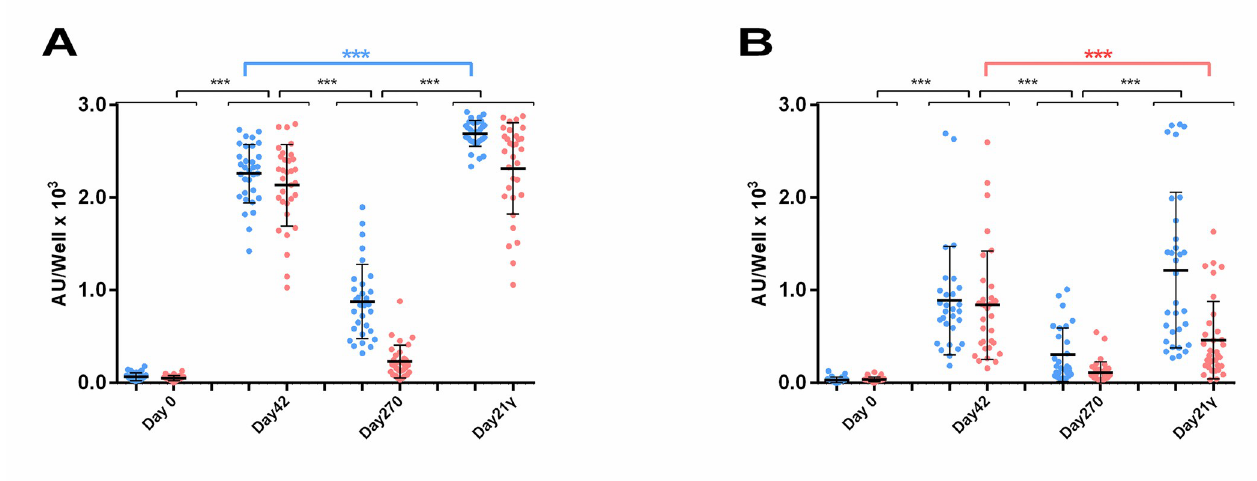
Fig 7. Antibody levels for 34 HCWs who received a third dose of the BNT162b2 mRNA vaccine. IgG (A) and IgA (B) anti-S (blue) and anti-RBD (red) Abs were measured on Day0, 42, 90, 270 days after the first dose on Day0 and on Day21 γ , 21 days after the third dose. Asterisks ( ��� ) indicate statistically significant differences ( p -value: < 0.001). Each dot represents an individual and error bars represent the mean value and standard deviation of the distribution.